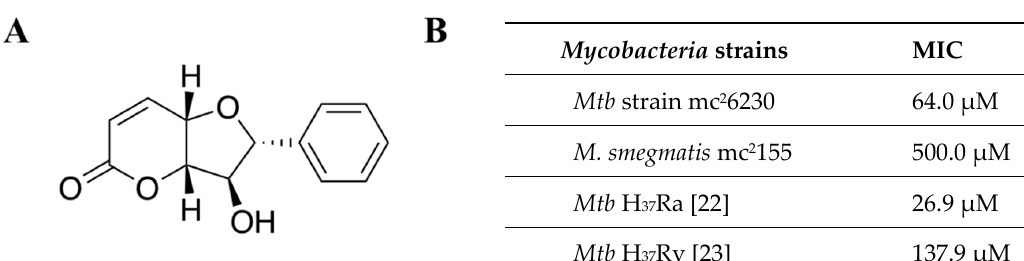
Figure 1. Overview of natural product drug discovery using both phenotypic screening and target screening approaches. A high throughput phenotypic screening of 202,983 Nature Bank (NB) lead-like enhanced (LLE) fractions [20] against M. tuberculosis H 37 Rv was initially performed. Active fractions were screened against a panel of 37 putative anti-tuberculosis (TB) targets from Mycobacteria species. To lower sample consumption, especially protein, nine active fractions were pooled (40 Pool Fractions) and incubated with each of the target proteins. The pooled fraction–protein mixtures were examined by native mass spectrometry to identify protein–ligand complexes. The mass shift between the protein (black) and the protein–ligand complex (red) peaks provided the molecular weight of the bound ligand.